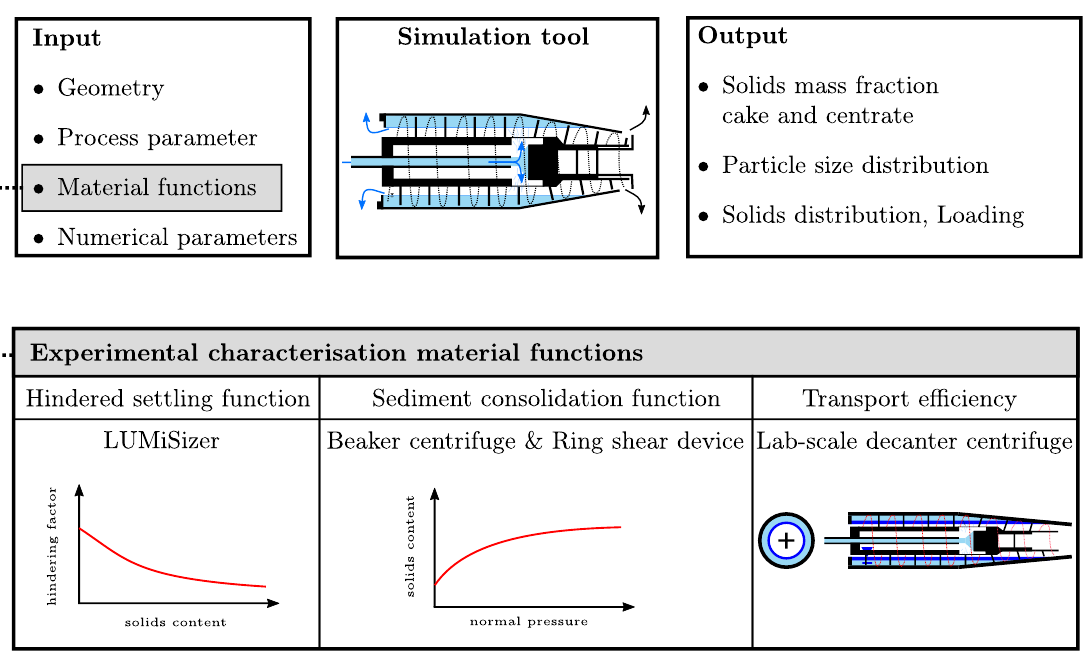
Figure 2. Overview of the required input and calculated output parameters with focus on material functions. The input parameters can be split into four different categories, as shown in Figure 2. The geometry and process parameters are either given by the centrifuge or